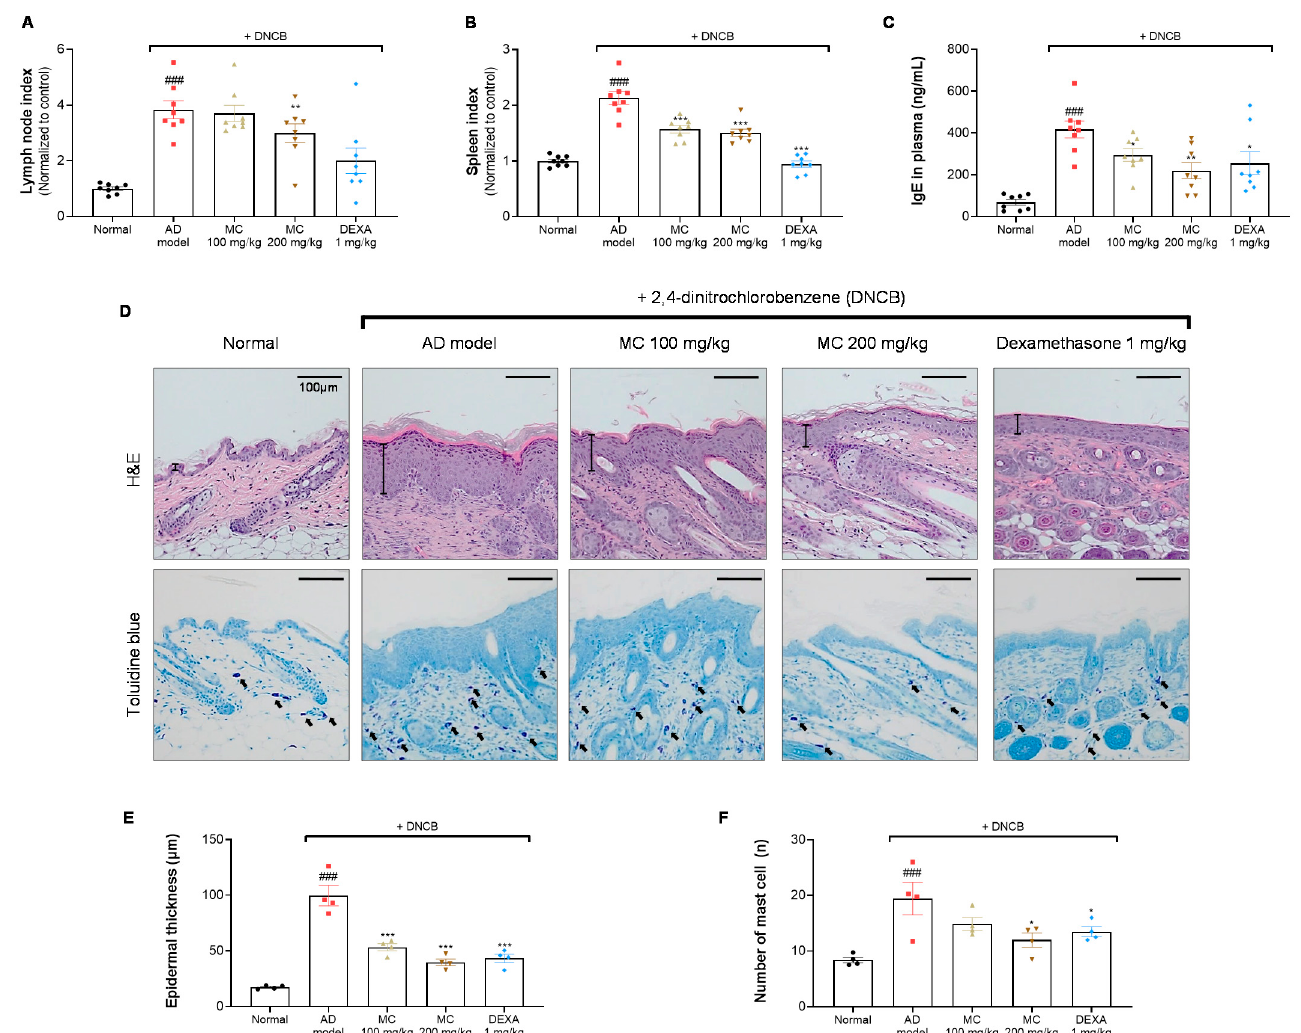
Figure 7. Effects of M. concanensis on histological and immunological changes in DNCB-induced AD. On day 21, the mice were sacrificed to investigate the immunological and histological differences. The lymph node ( A ) and spleen ( B ) indices were normalized to those in the normal group [Index = (organ weight/body weight) × 100] (n = 8). The plasma IgE concentration ( C ) was measured by an ELISA kit (n = 8). Images of hematoxylin and eosin (H&E) and toluidine blue (TB) staining of lesional dorsal skin ( D ) were obtained at 200× magnification, and characteristic images are shown; scale bar: 100 μ m. Epidermal thickness ( E ) and the number of mast cells ( F ) were counted (n = 4), and the data presented are mean ± S.E.M. ### p < 0.001 versus Normal. * p < 0.05, ** p < 0.01 and *** p < 0.001 versus the only DNCB-treated group. AD model; only DNCB-treated group, MC 100 mg/kg + DNCB; DNCB-induced mice administered with 100 mg/kg of M. concanensis , MC 200 mg/kg + DNCB; DNCB-induced mice administered with 200 mg/kg of M. concanensis , DEXA 1 mg/kg +